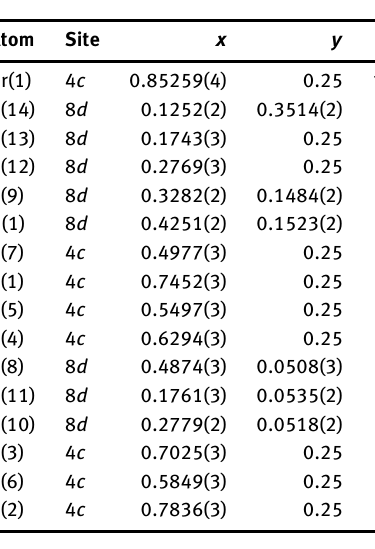
Table 3: Fractional coordinates and displacement parameters (Å 2